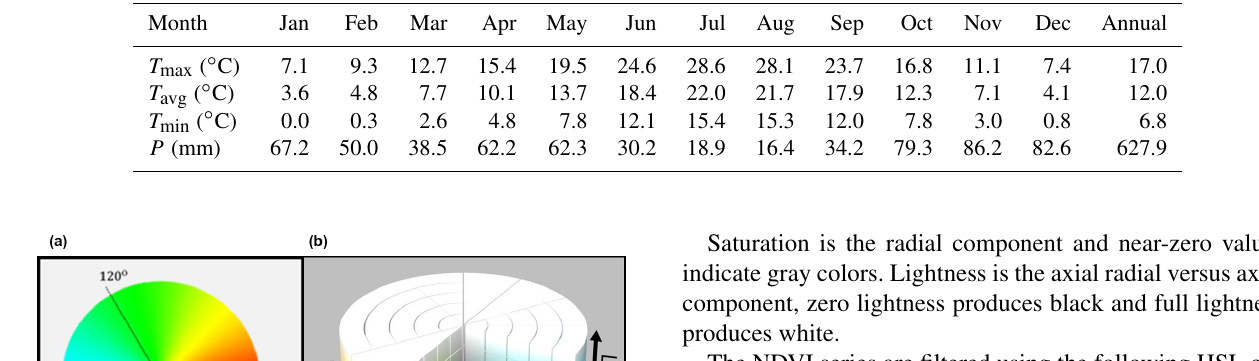
Figure 1. The study area is in the center of the Iberian Peninsula (Community of Madrid). RGB image of the 6-pixel area used for the case study is shown (© Google Earth and MODIS images). Table 1. Monthly average of maximum temperature ( T max ), average temperature ( T avg ), minimum temperature ( T min ) and precipitation ( P ). Study period from 1997 to 2017.